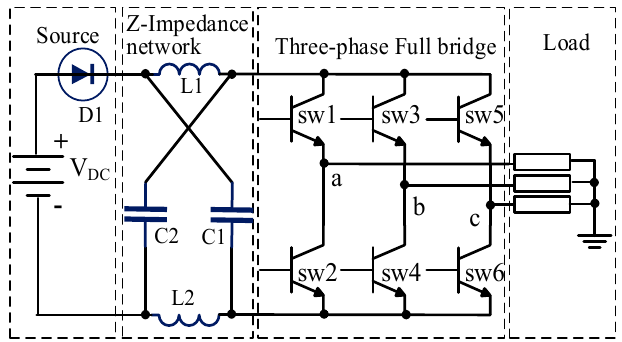
Figure 4. Electrical diagram of a three-phase full-bridge Z-source inverter.